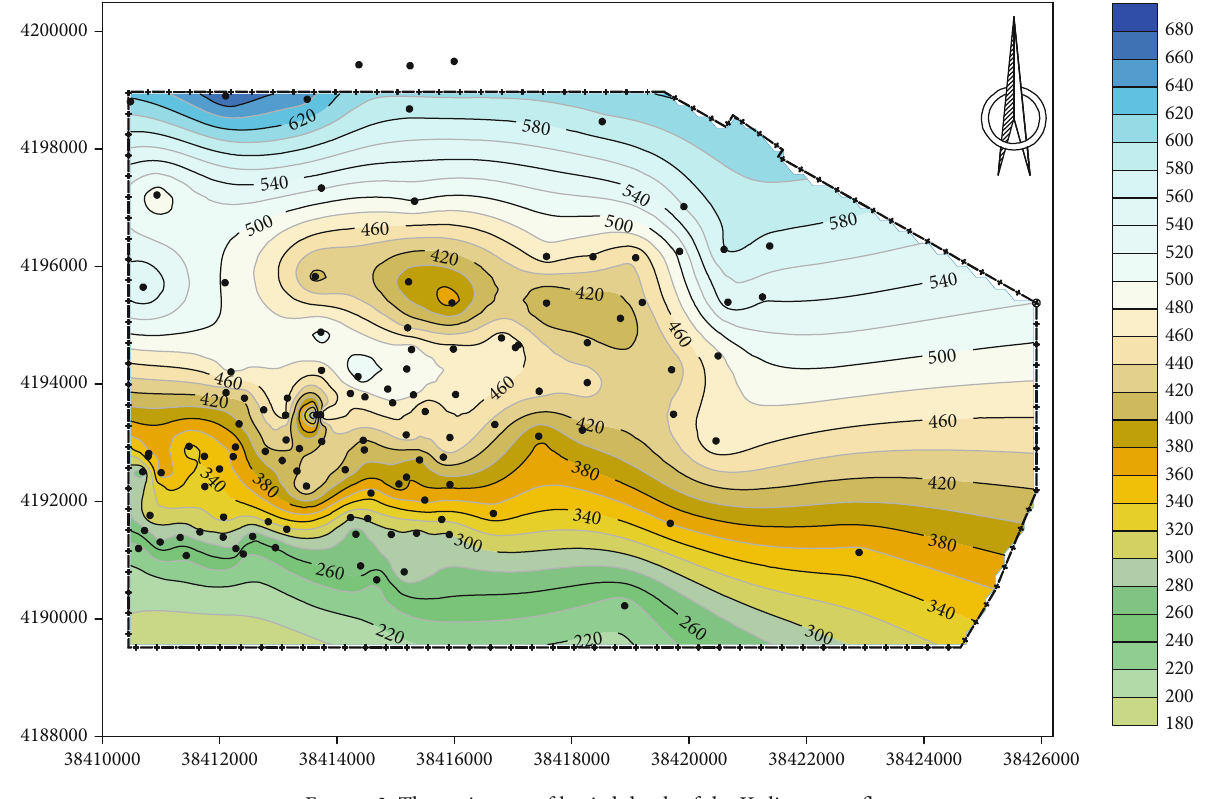
limestone fl oor. 2